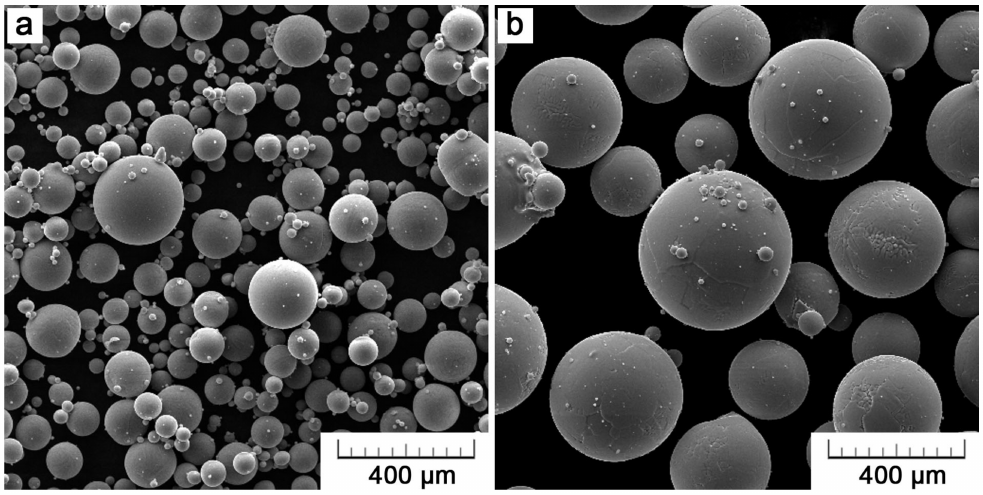
Figure 1. Morphology of Ti6Al4V powder for: ( a ) Selective Laser Melting (SLM) and ( b ) Electron Beam Melting (EBM) technology.